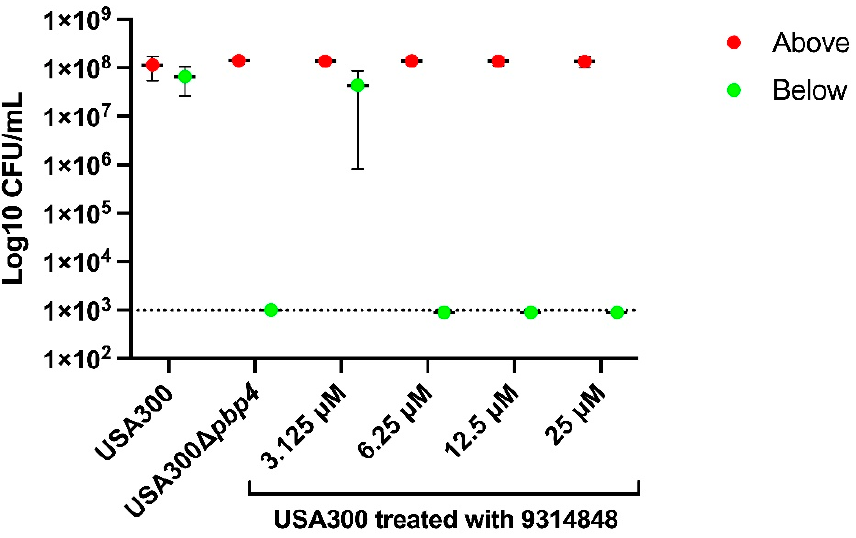
Figure 5. µSiM-CA assays . Enumeration of wild type USA300, USA300 ∆ pbp4 , and wild type cells treated with 0, 3.1, 6.2, 12.5, 25.0, or 50.0 µM 9314848 recovered.